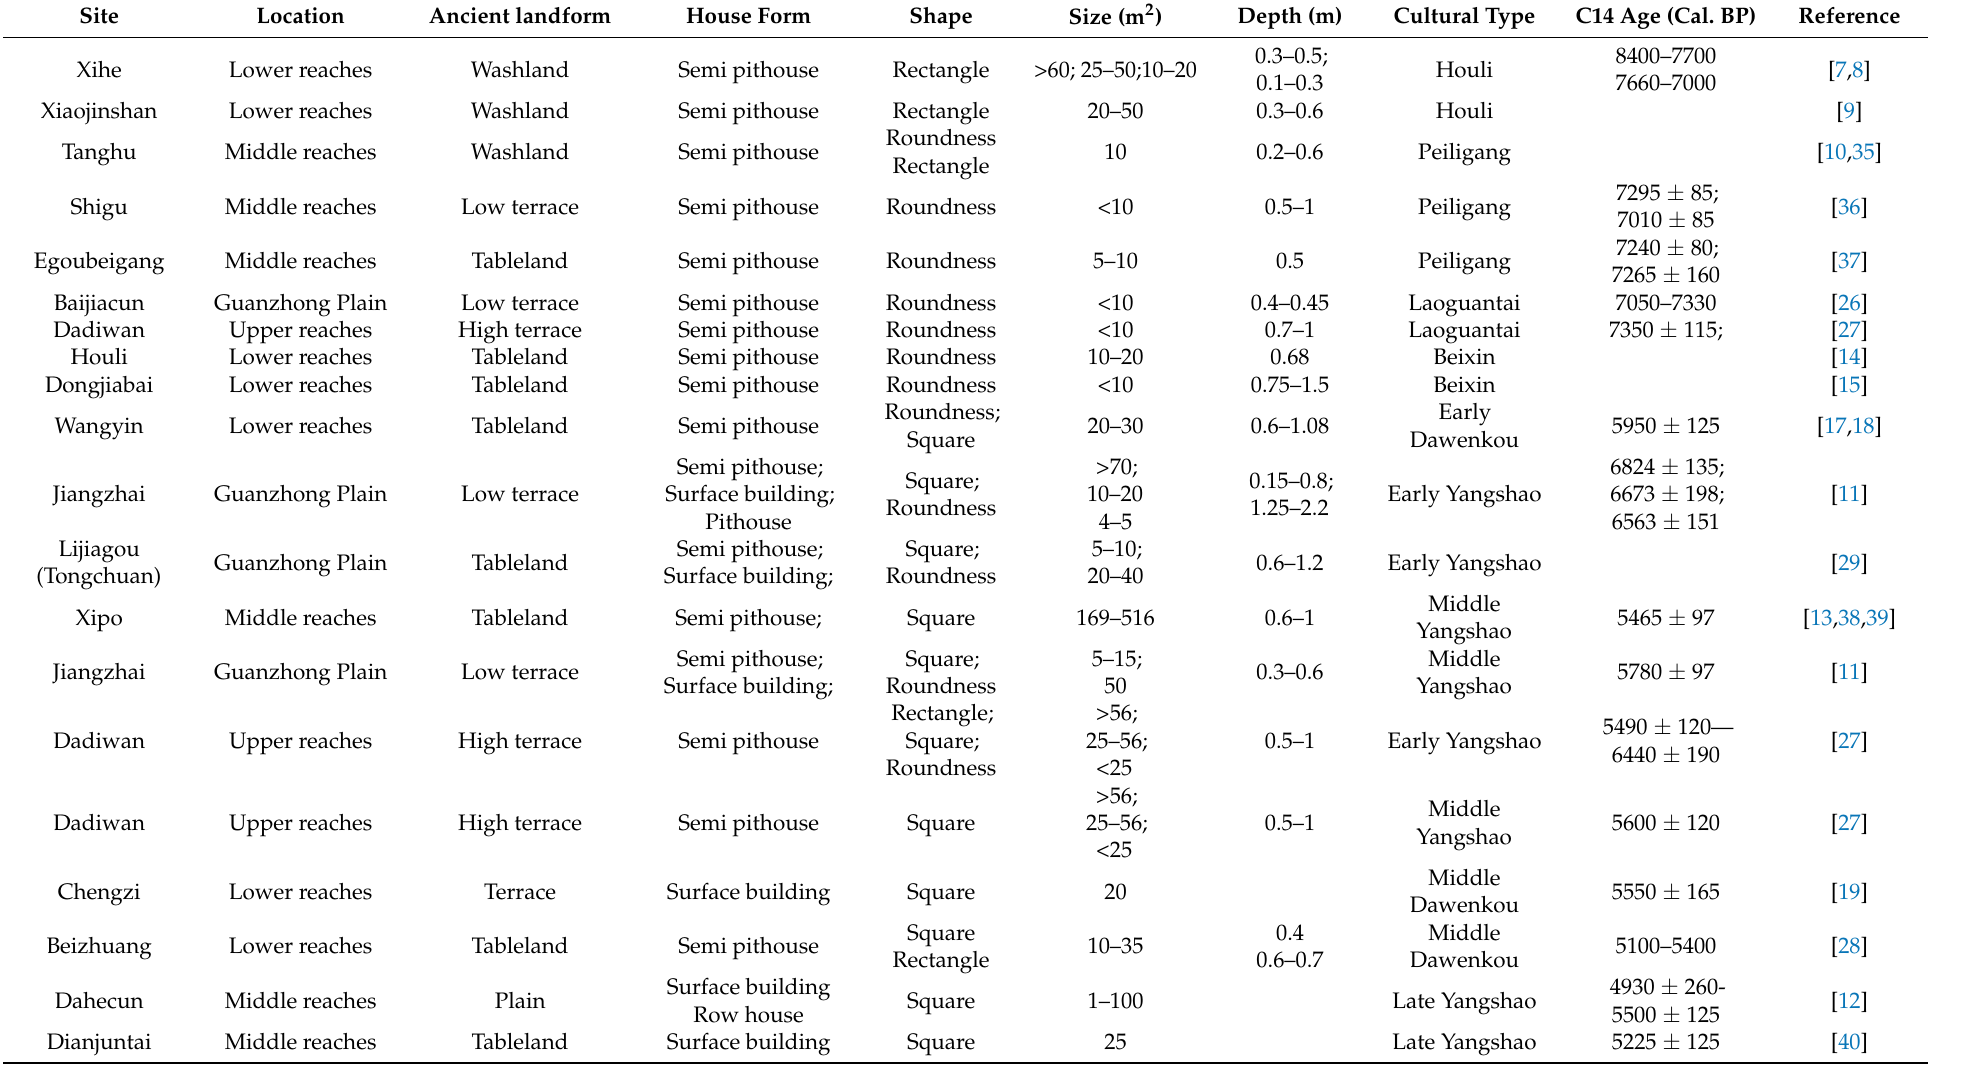
Table 1. The basic feature of the typical sites and ancient houses (the sites are arranged in chronological